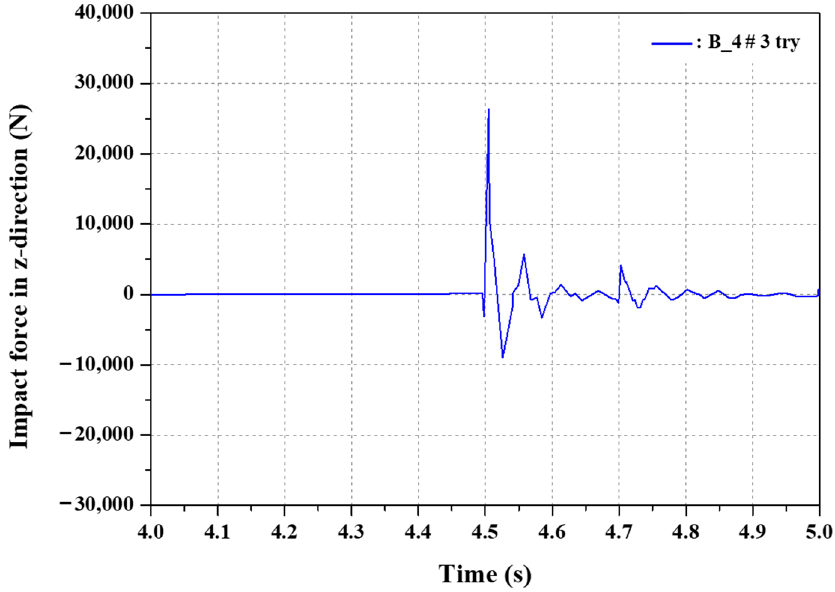
Figure 9. Example of time-load history for B-4 case. Table 6. Experimental results for all scenarios.